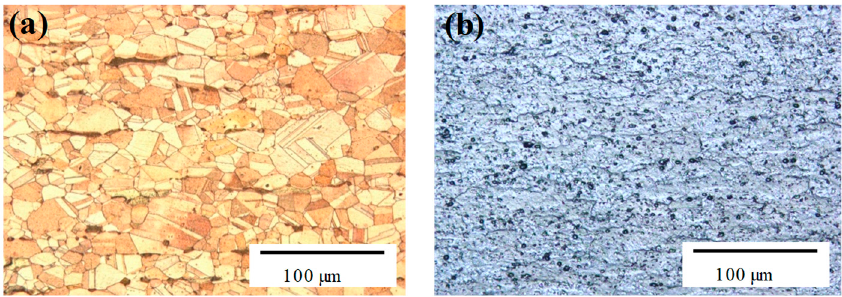
Figure 11. The microstructure of as-received metals; ( a ) C2801P alloy and ( b ) AA6061-O alloy.